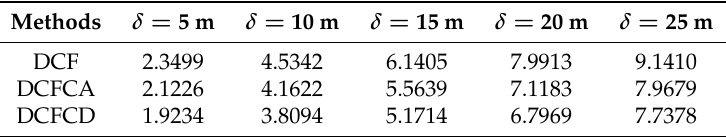
Table 3. Position ARMSE of different measurement noise covariances.